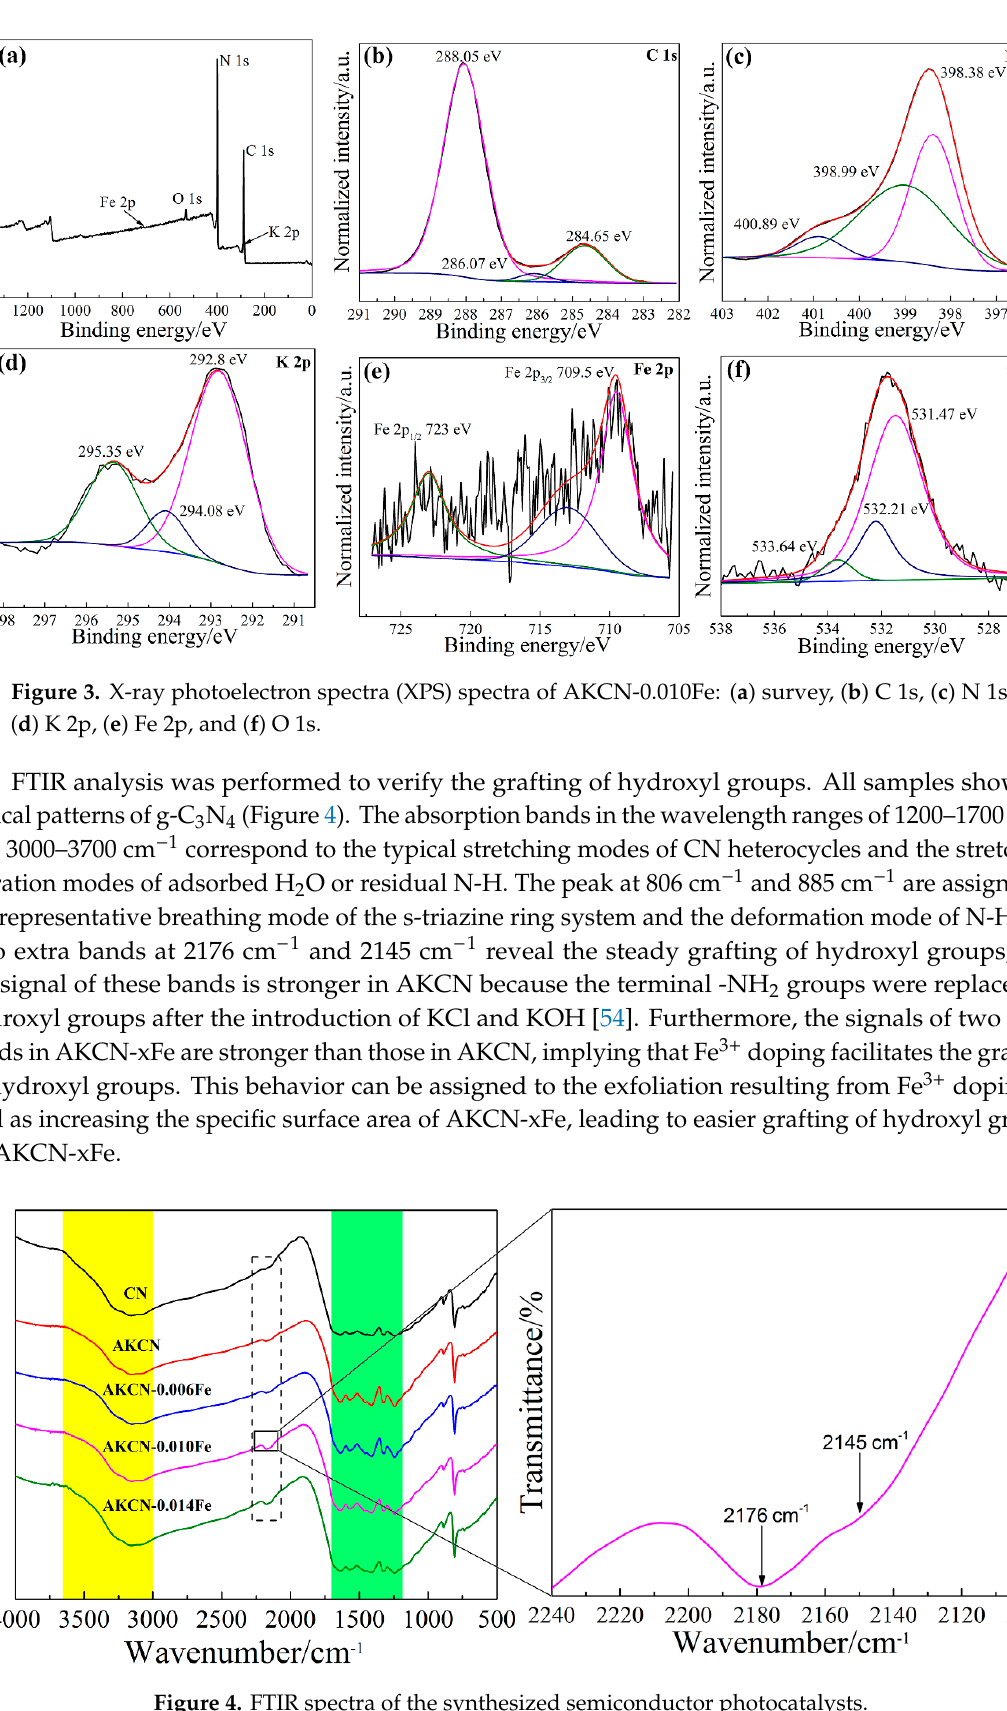
Figure 4. FTIR spectra of the synthesized semiconductor photocatalysts.